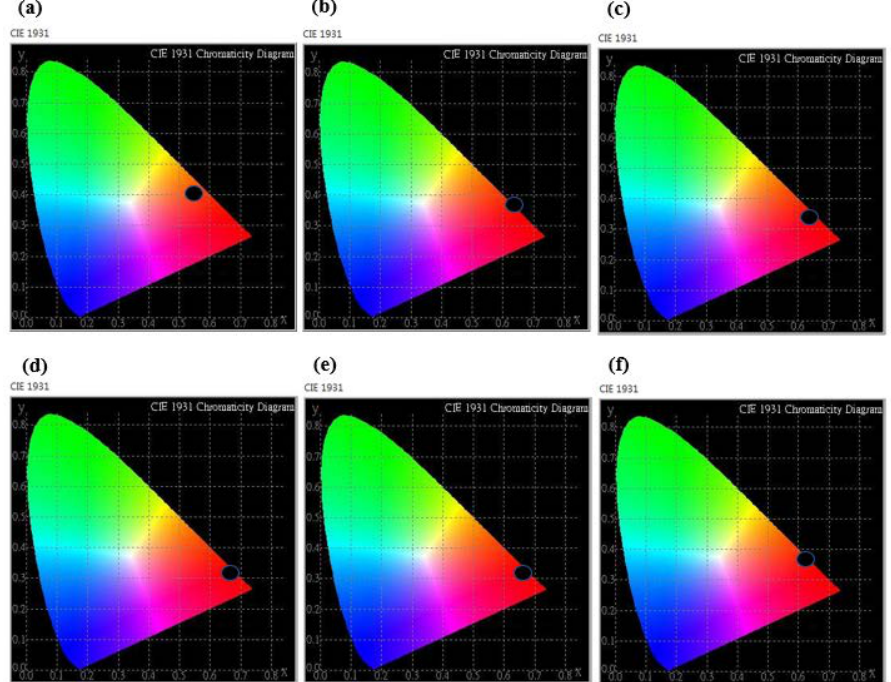
Figure 8. The CIE chromaticity coordinates of CaAlSiN 3 :Eu 2+ phosphors doped with 0.02 molar ratio of Eu 2+ under the excitation of 460 nm with Al = 0.2 ( a ); 0.5 ( b ); 0.8 ( c ); 1.0 ( d ); 1.2 ( e ); and 1.5 ( f